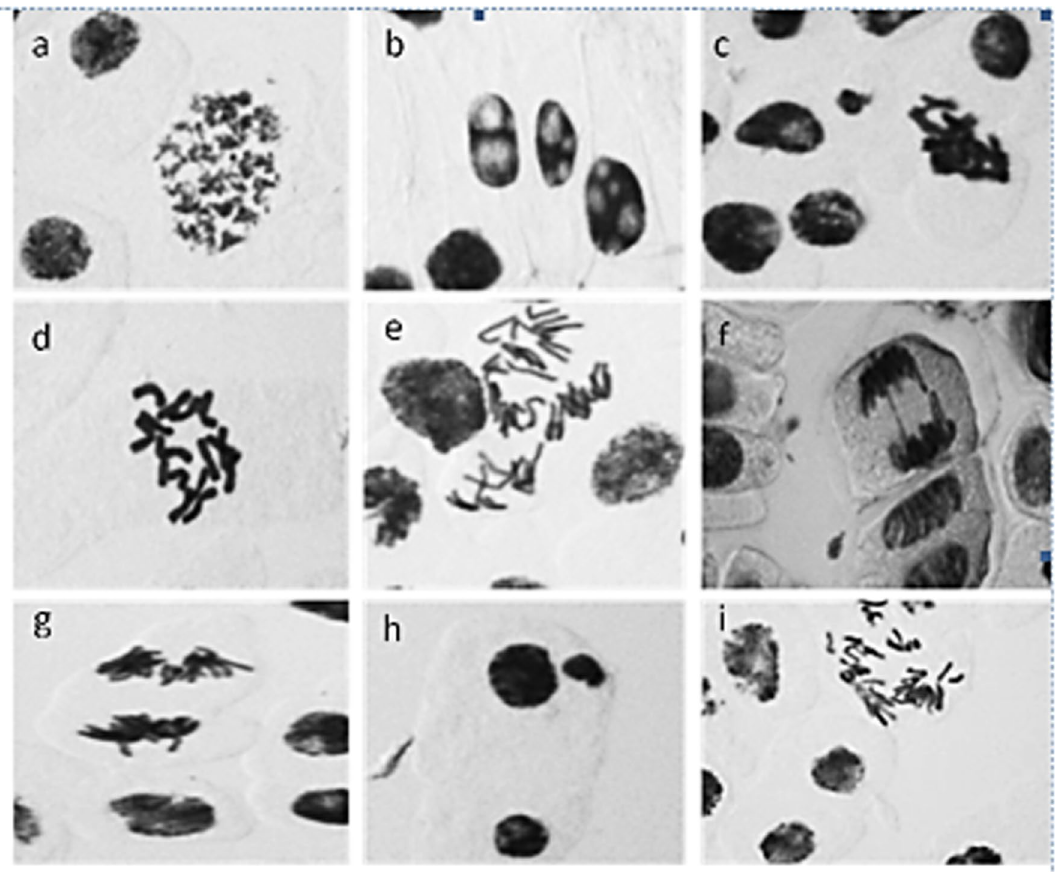
Fig. 4 Different types of mitotic aberrations recorded by treated mixed water on Allium cepa root cells. a Goat cell, b vacuolated cells, c sticky cell and micronuclei, d c‑metaphase, e c‑anaphase, f anaphase, bridge, g multipolar cell, h micronucleus and i disturbed anaphase